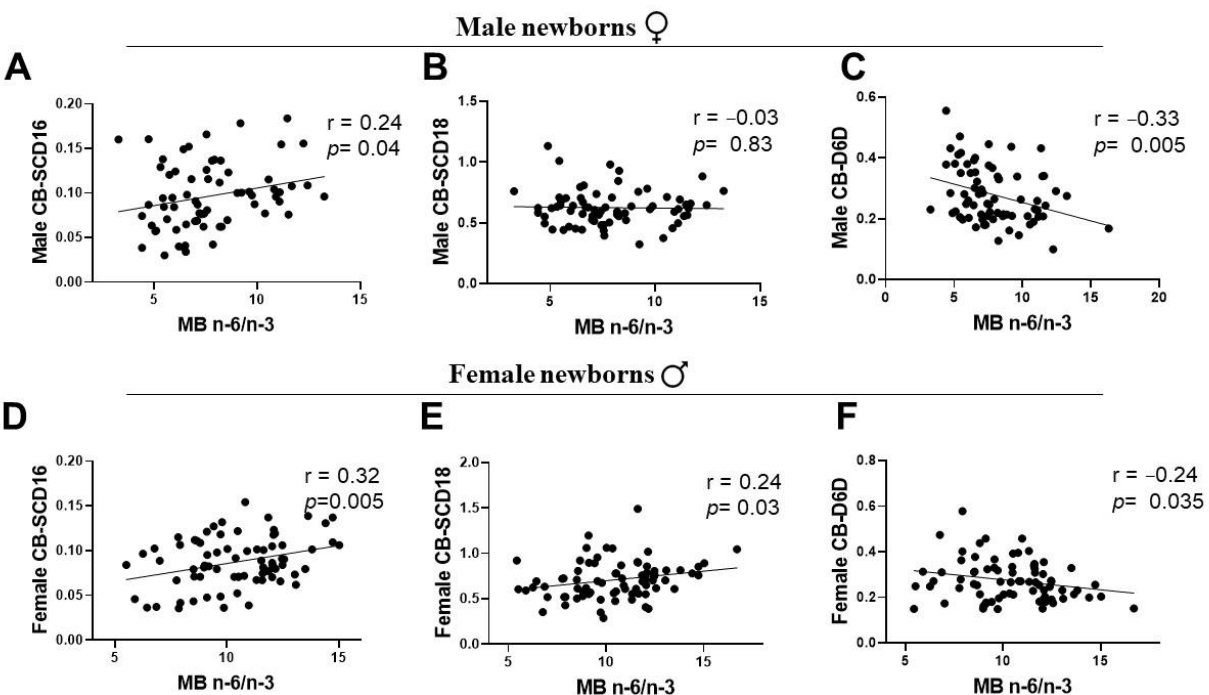
Figure 5. Cord blood desaturation indices are differently related to maternal total n-6/n-3 ratio PUFA status in the newborn gender groups. ( A – C ) Male newborns. ( D – F ) Female newborns. Pearson r and p values are shown. PUFA, polyunsaturated fatty acid.